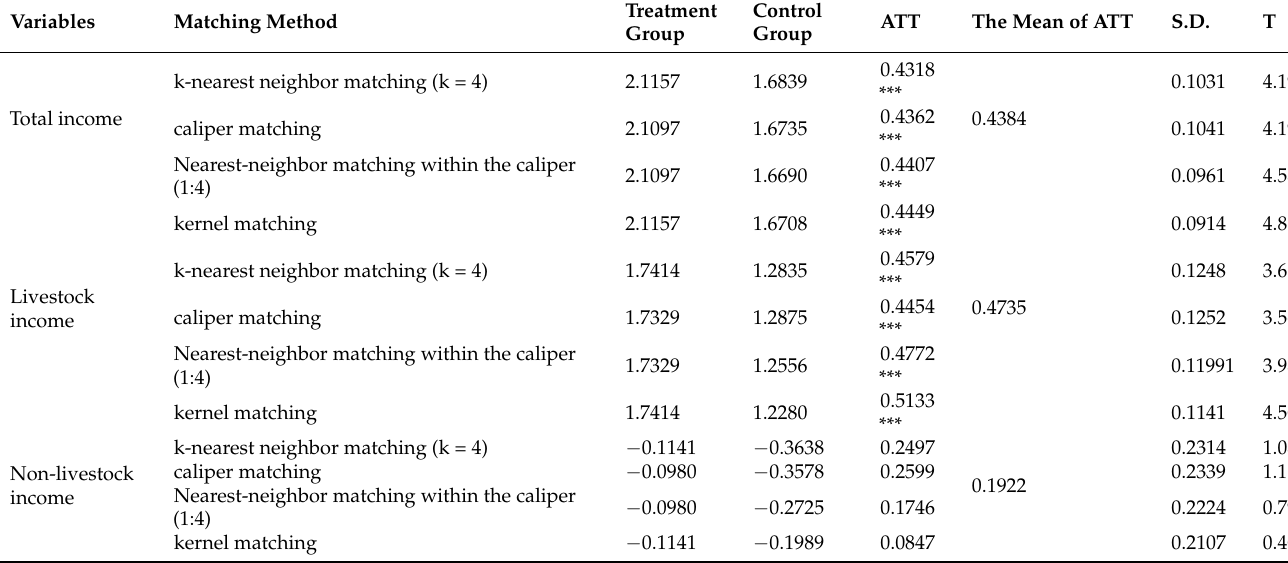
Table 5. PSM results of grassland transfer on herder